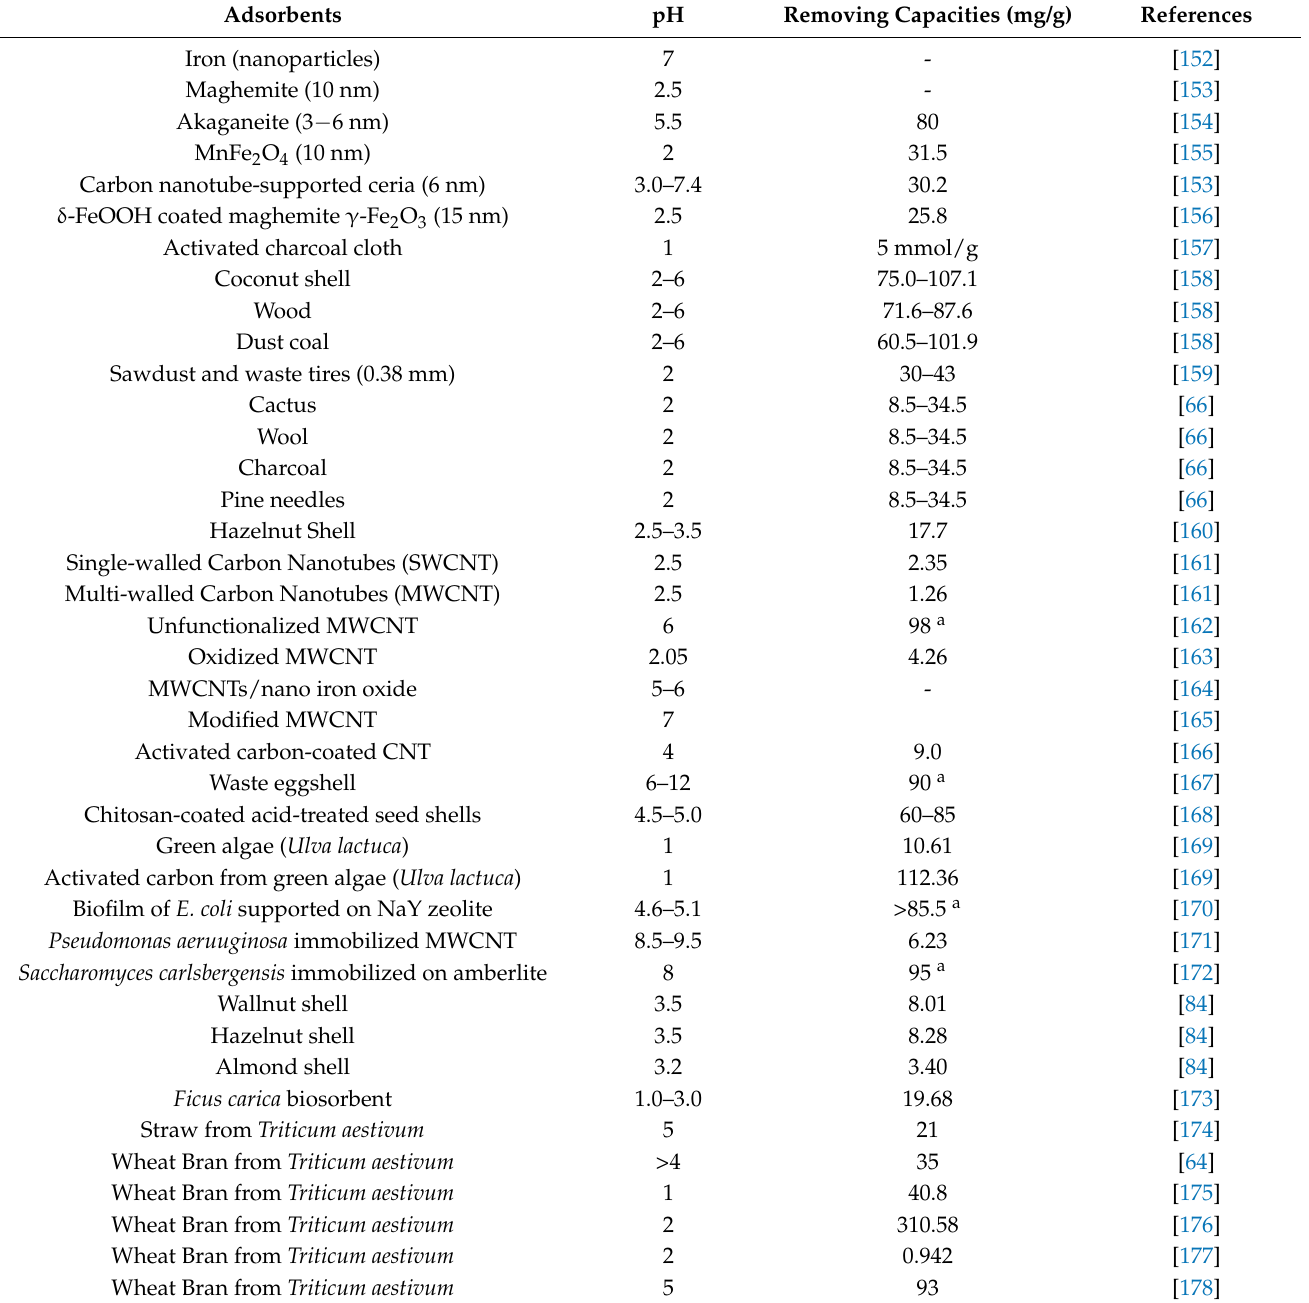
Table 3. Cr removal capacities of available adsorbents in the literature. (The superscripts a and b represent the results in percentages (%) and